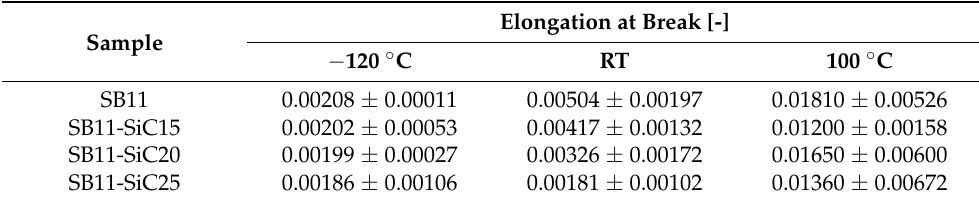
Table 3. Elongation at break of composites determined from the